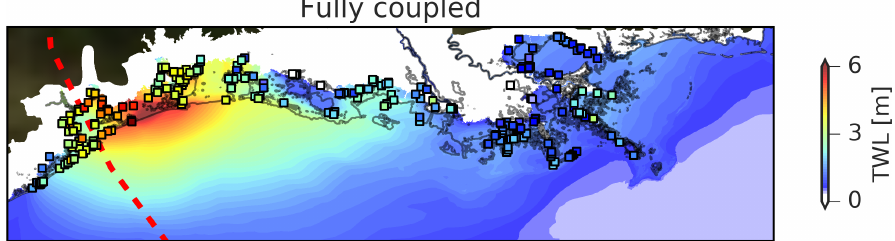
Figure 15. High Water Mark observations for Hurricane Ike, 2008. The contour plot is the total water level for the Fully coupled case. All model configurations and results are pre-decisional and for official use only.